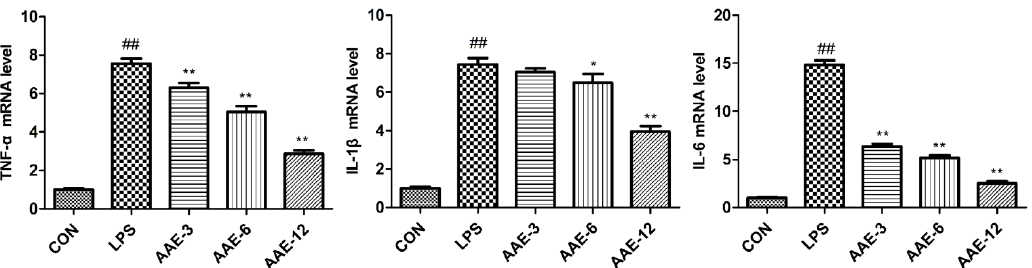
vs. CON. * p < 0.05 and ** p < 0.01 vs. LPS.